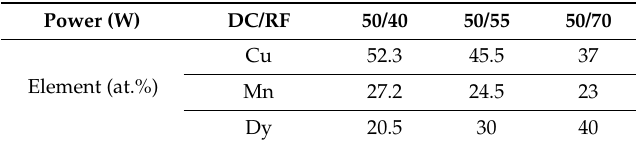
Table 1. Compositions of Cu–Mn–Dy thin films prepared at a direct current (DC) 50 W with different radio frequency (RF) powers sputtered on cooper sheet.